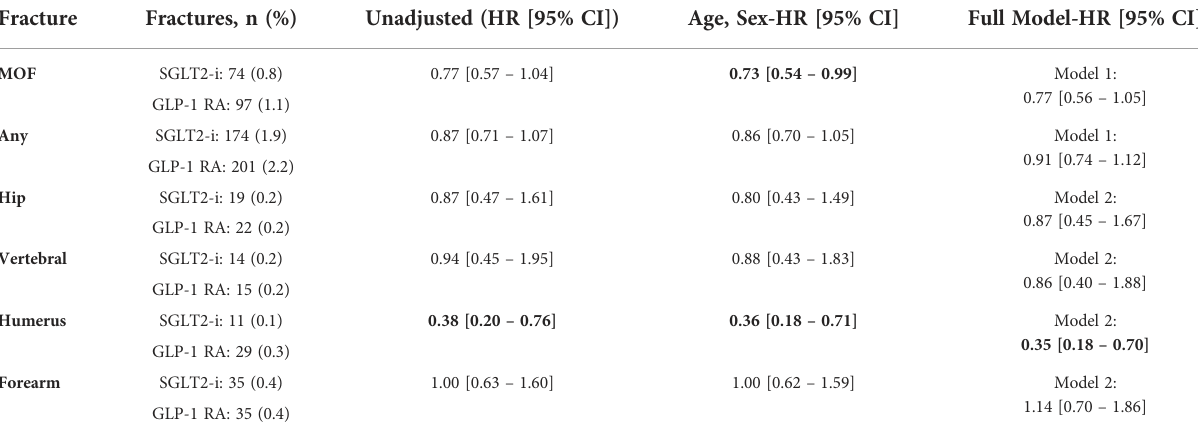
HR, Hazard Ratio; MOF, major osteoporotic fracture; SGLT2-i, sodium-glucose cotransporter 2 inhibitor; GLP-1 RA, glucagon-like peptide-1 receptor agonists; Bold font: the HR was signi fi cantly different from 1.00. Full model 1: Adjusted for sex, age, inclusion date, diabetes duration, Charlson Comorbidity Index, diabetic nephropathy, diabetic retinopathy, diabetic neuropathy, previous falls, in fl ammatory bowel disease, previous insulin use, previous glucocorticoid use, osteoporosis (including prevalent MOF), hypertension, kidney disease, alcohol, smoking, obesity, income, chronic pancreatitis, visual impairment, hyperthyroidism, hyperparathyroidism, eating disorder/malabsorption. Full model 2: Corresponding to Model 1 but excluding chronic pancreatitis, diabetic neuropathy, visual impairment, hyperthyroidism, hyperparathyroidism and eating disorder/ malabsorption as